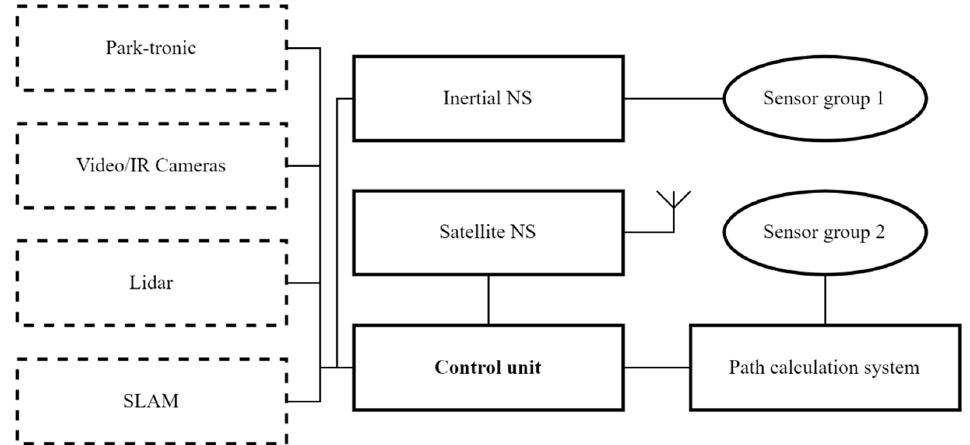
Figure 4. Block diagram of various variants of navigation and control equipment of the robotic plat- form.